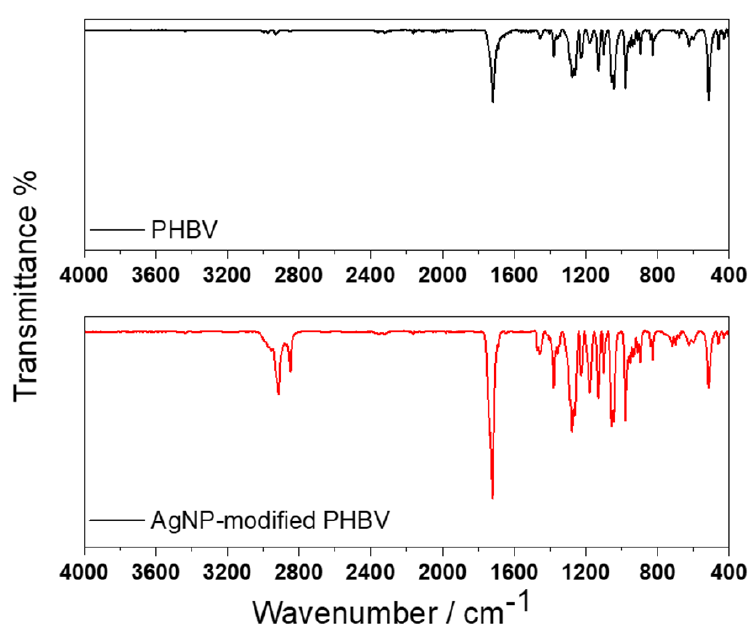
Figure 2. ATR-IR spectra of pristine (black line) and AgNP-modified (red line) PHBV samples. Table 1. Spectral IR regions of interest. ν indicates symmetrical (s), asymmetrical (a) stretching; δ represents vibrational distortions in conjugated molecules. Uncertainty on positions is 2 cm − 1 . Attributions Spectral Regions (cm − 1